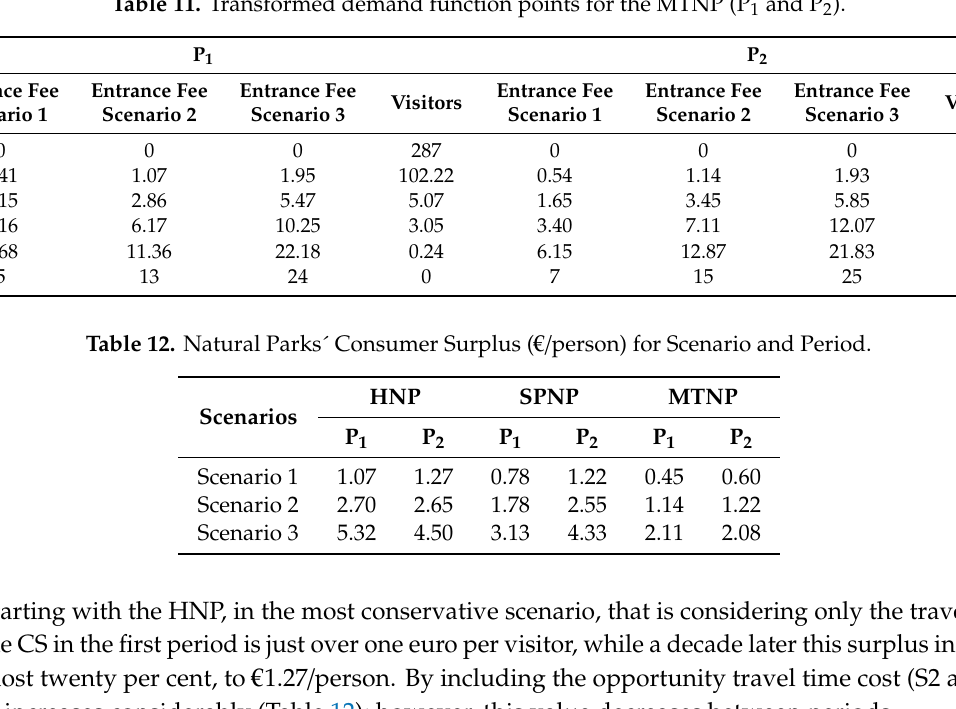
Table 11. Transformed demand function points for the MTNP (P 1 and P 2 ).